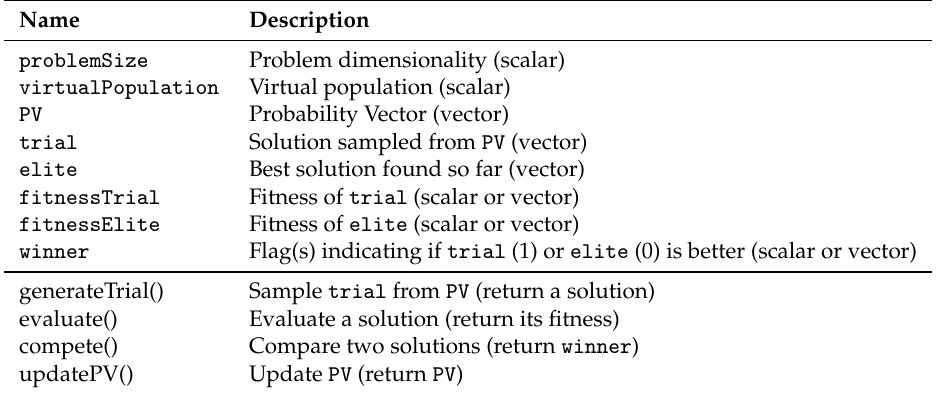
Table 1. Variables and functions used in the binary cGAs.